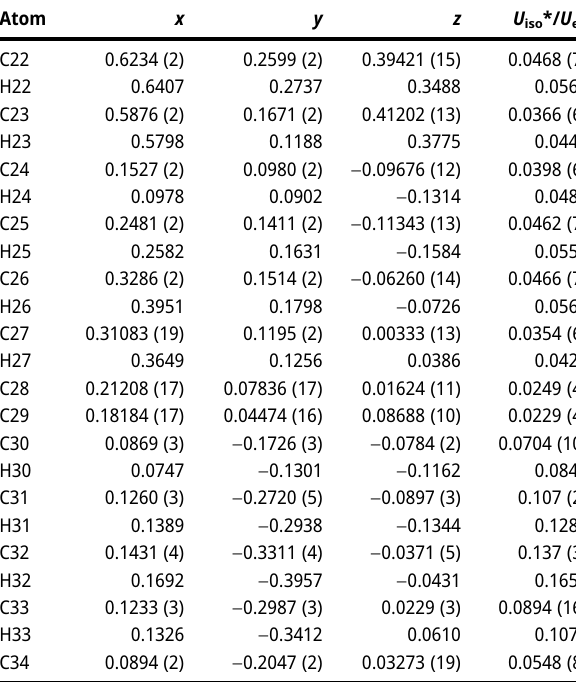
Table  : Fractional atomic coordinates and isotropic or equivalent isotropic displacement parameters (Å 